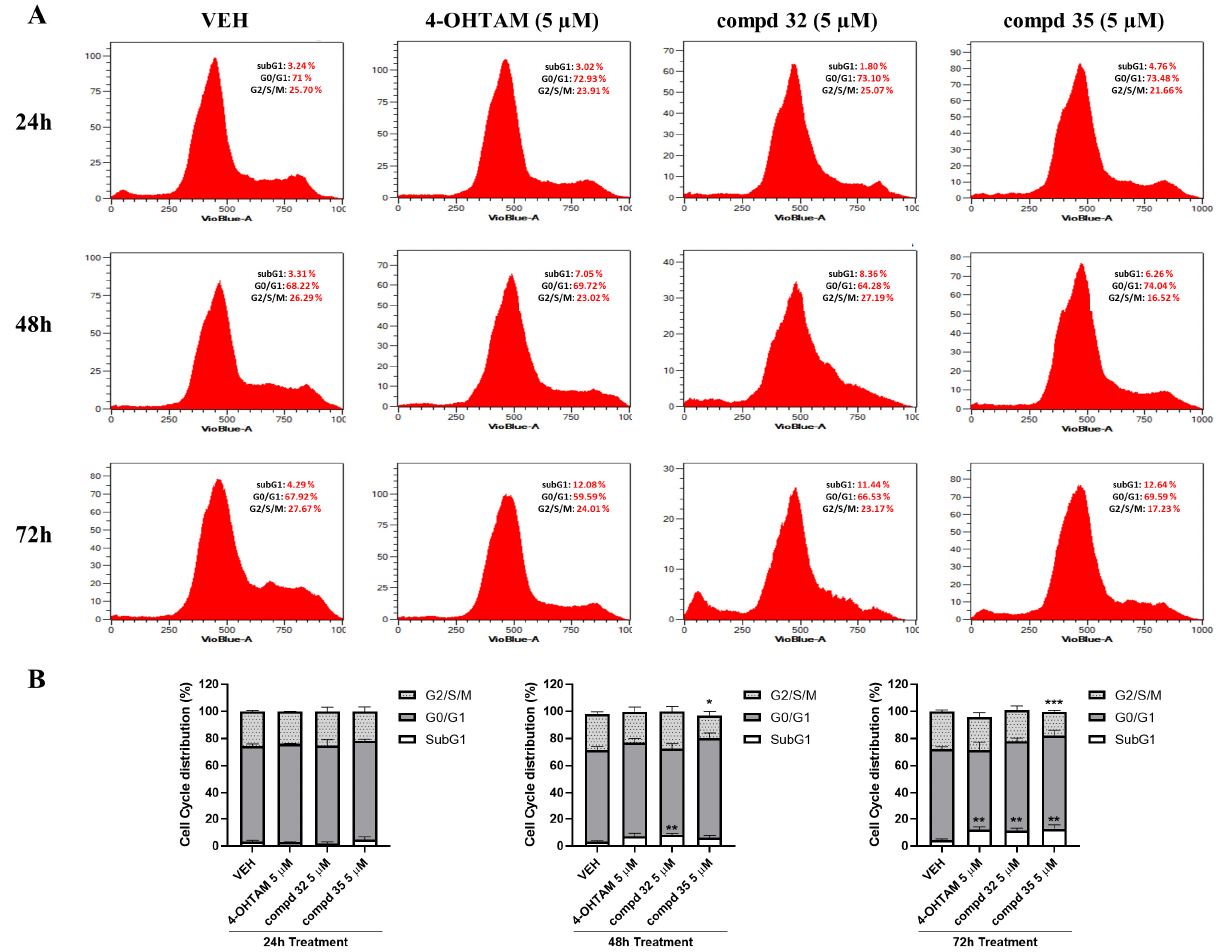
Figure 12. 5-Hydroxy-2 H -pyrrol-2-ones 32 and 35 block cell cycle entry in human ER+ breast cancer cells in a time-dependent manner. Cell cycle studies were performed in T47D cells treated with ve- hicle (VEH, 0.05% DMSO), 4-OHT (5 µM), compounds 32 or 35 (both, 5 µM) for 24h, 48 h or 72 h.